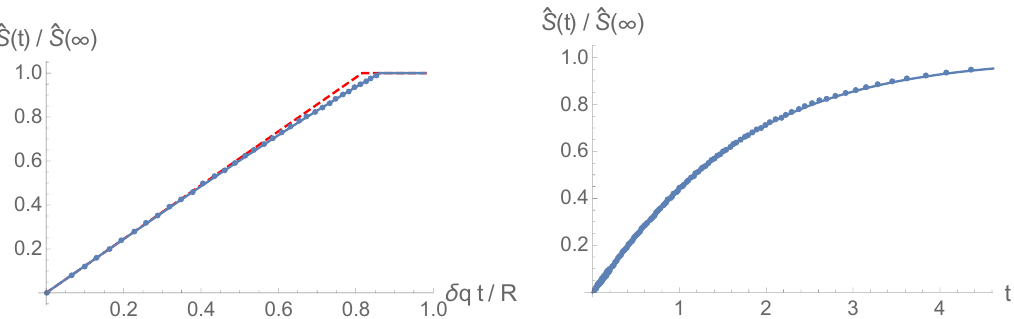
q 3 (cid:14)q 8 q 3 v E . p q 4 (cid:29)